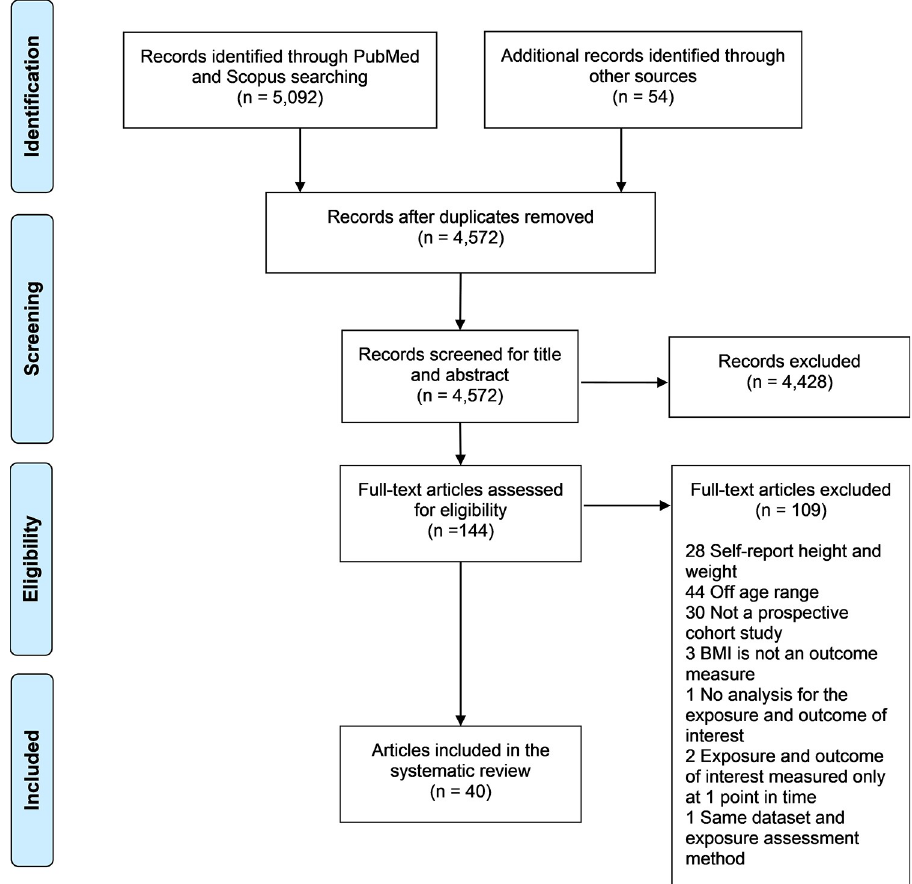
Fig 1. PRISMA flow diagram of study selection